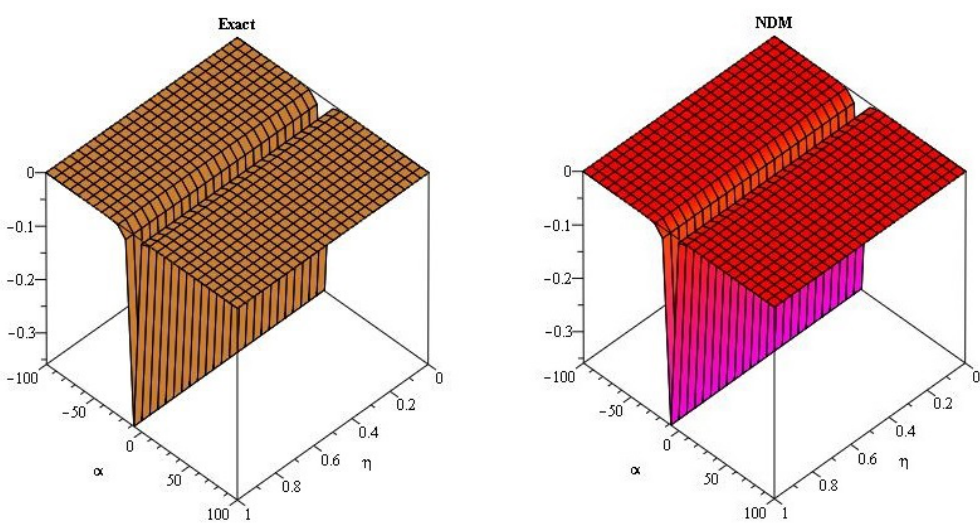
Figure 8. Exact and NDM solution of ν ( α , η ) at δ = 1.